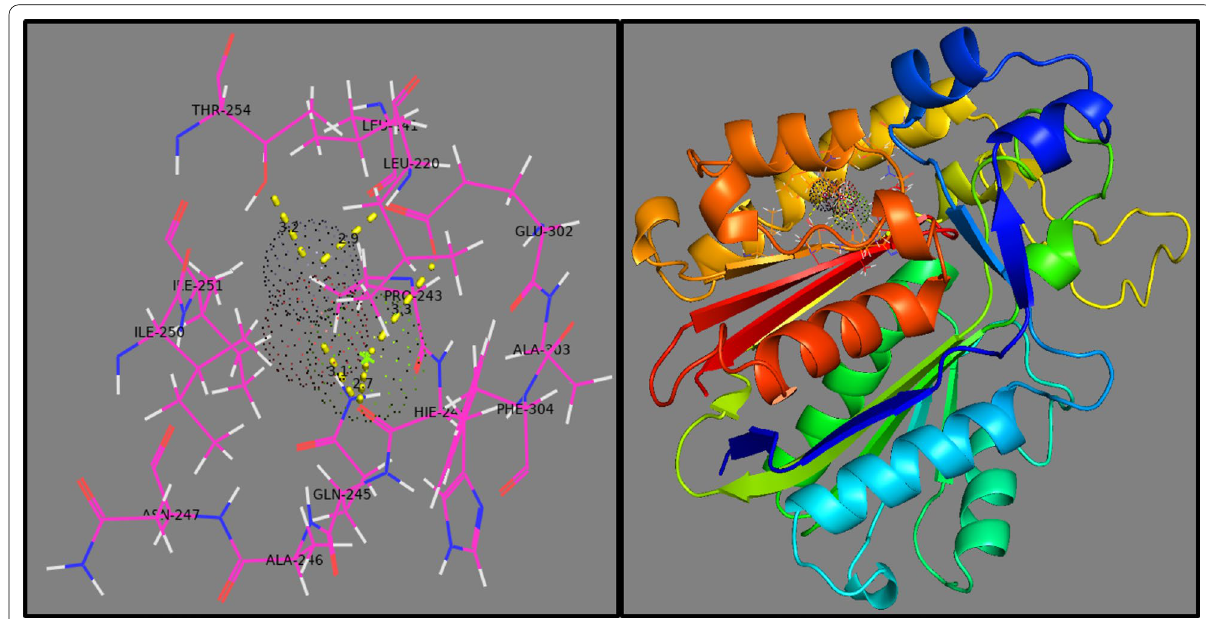
Fig. 12 Binding interaction pattern of Mg‑doped ZnO NRs inside active pocket β ‑ketoacyl‑acyl carrier protein synthase III (FabH) from E.